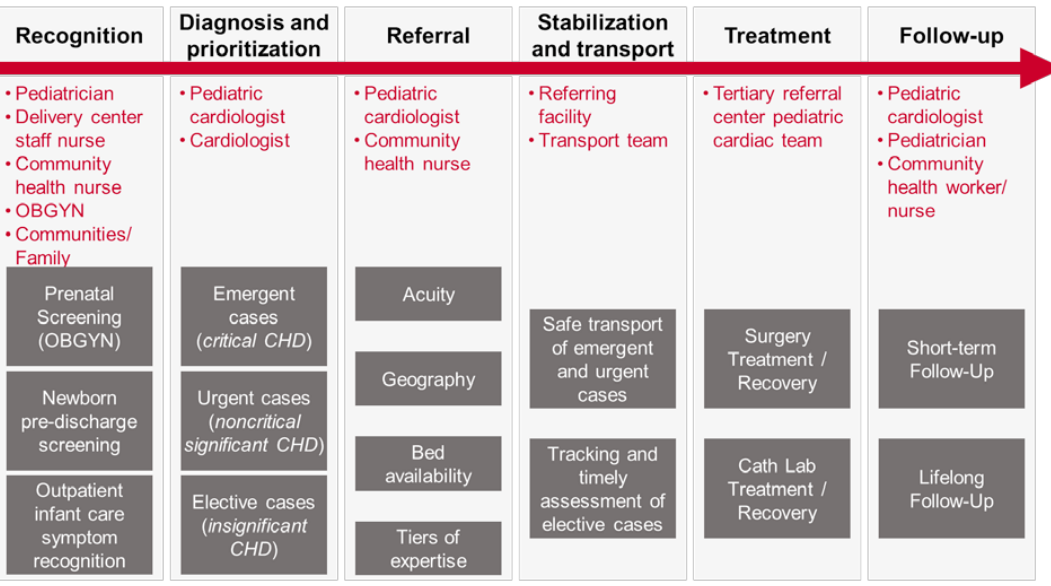
Figure 1. Congenital heart disease (CHD) patient care continuum.